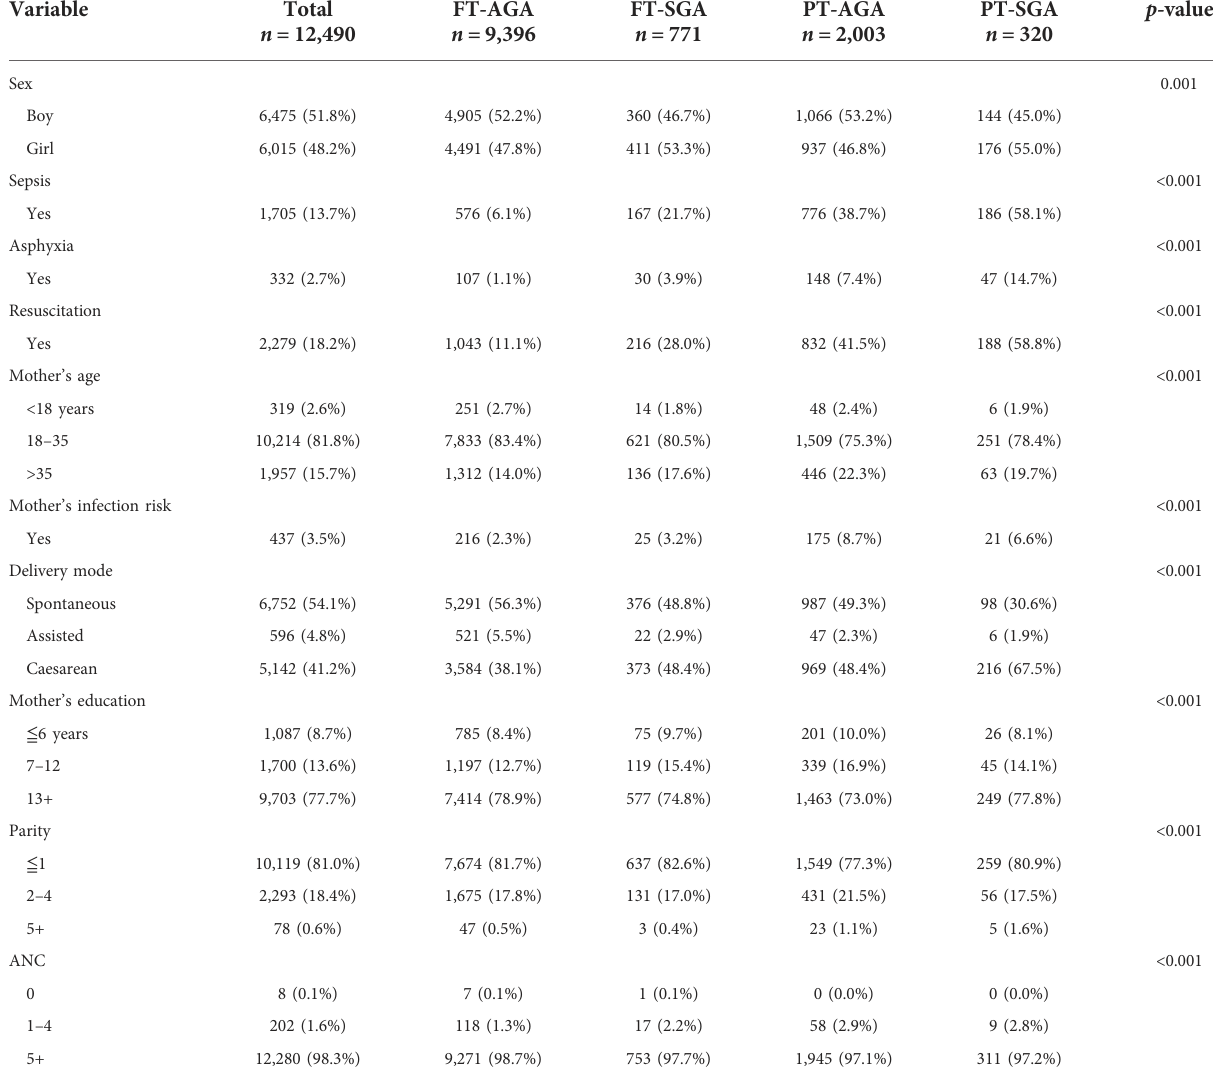
TABLE 1 Characteristics of newborn and mother by full-term preterm and